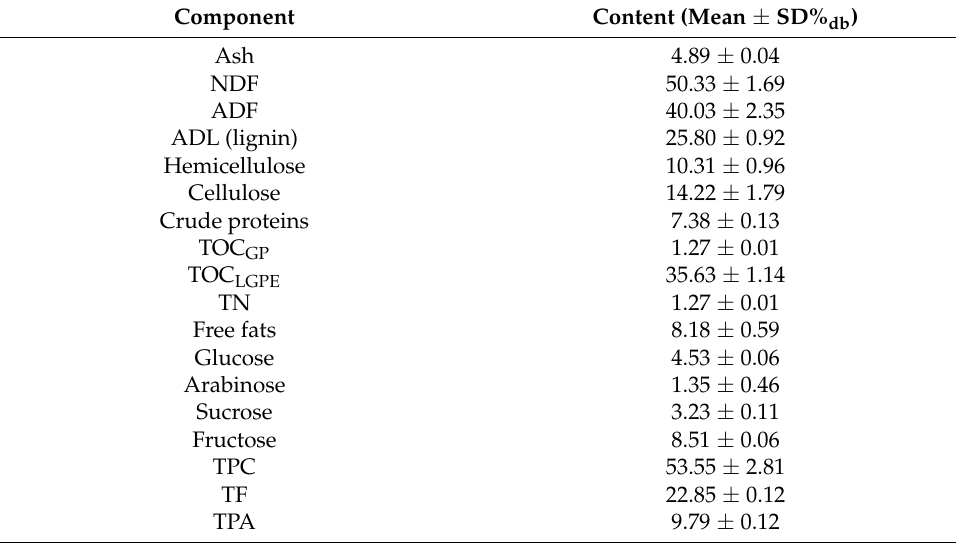
Table 3. Chemical composition of grape pomace Cabernet Sauvignon variety.